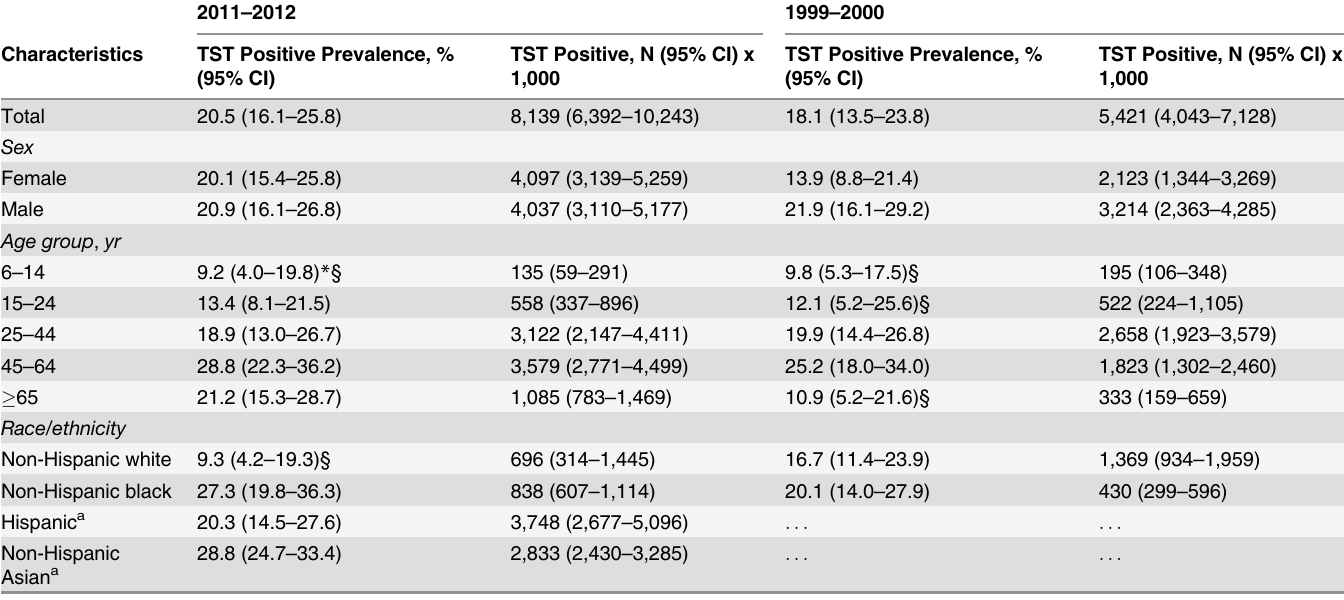
Table 3. Tuberculin Skin Test Positive Prevalence in the Civilian, Noninstitutionalized Foreign-born Population, Ages 6+, United States, 2011 – 2012 and 1999 –